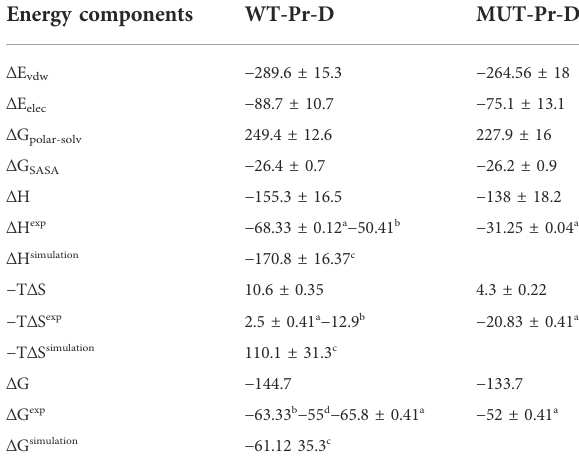
TABLE 1 Comparison of binding energy components between the protease and DRV in the WT-Pr-D and MUT-Pr-D systems. Also, other experimental and simulation studies about DRV binding to some mutant HIV-1 proteases were shown. Energy